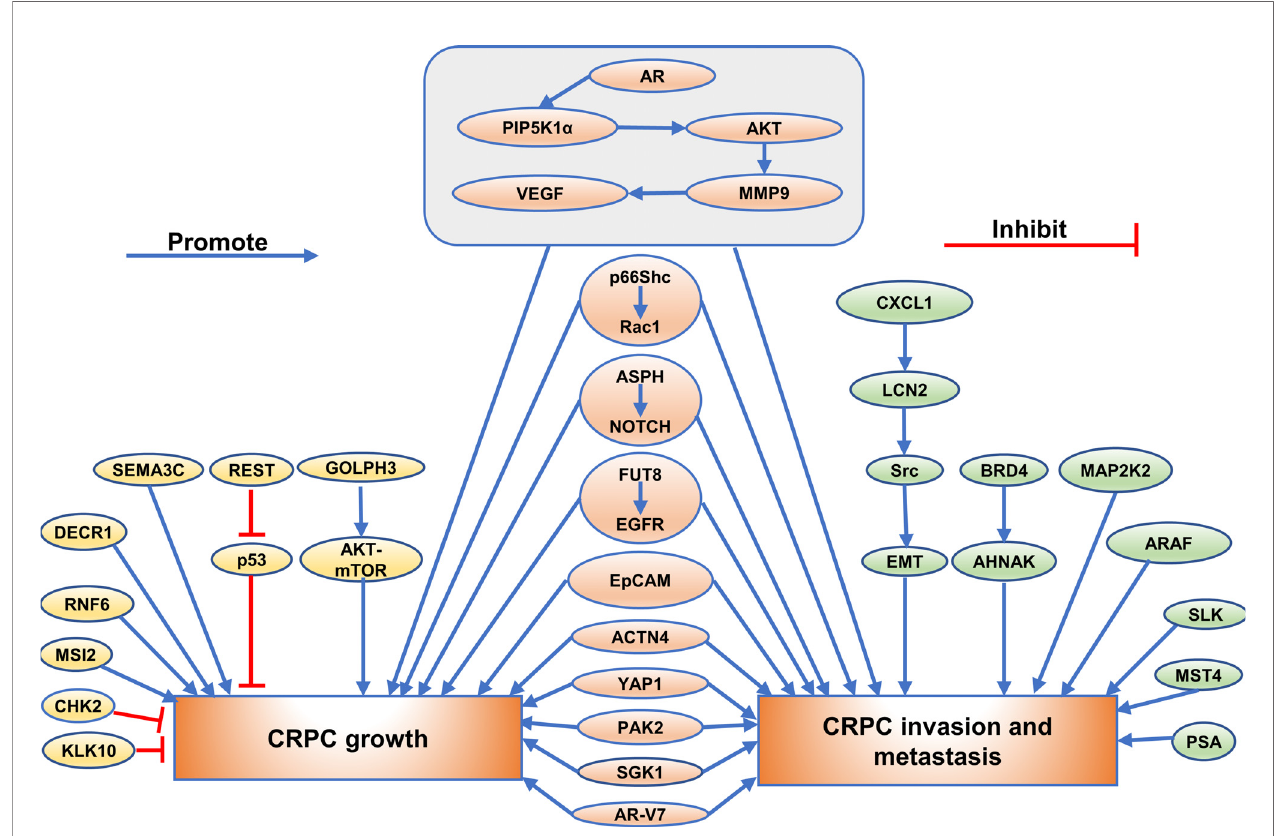
FIGURE 1 | The role of emerging proteins in CRPC growth, invasion and metastasis. The emerging proteins involved in CRPC growth are showing as golden, and the proteins involved in CRPC invasion and metastasis are showing as green. The proteins involved in both CRPC growth and CRPC invasion and metastasis are showing as